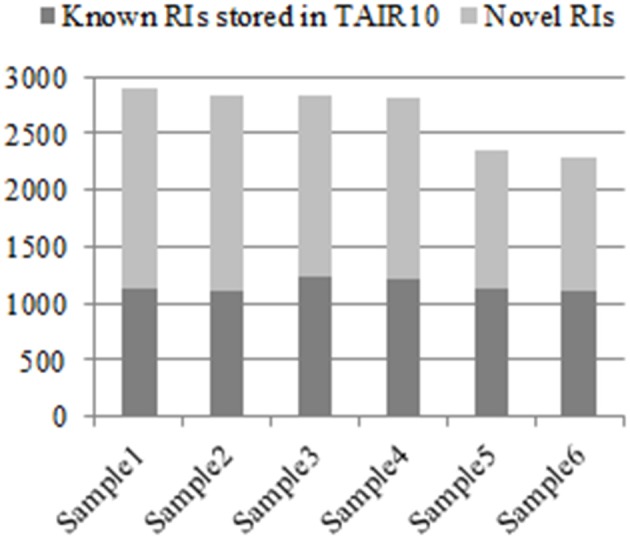
The known RIs in TAIR10 and novel discovered RIs respectively in six classes of RNA-Seq datasets. All experimental RNA-Seq datasets for analysis are divided into six classes: Sample1, Sample2, Sample3, Sample4, Sample5, and Sample6. For each class, that the discovered RIs are novel means they are unknown in TAIR10 but newly detected by our method, which depicted with light gray, and contrarily with dark gray.